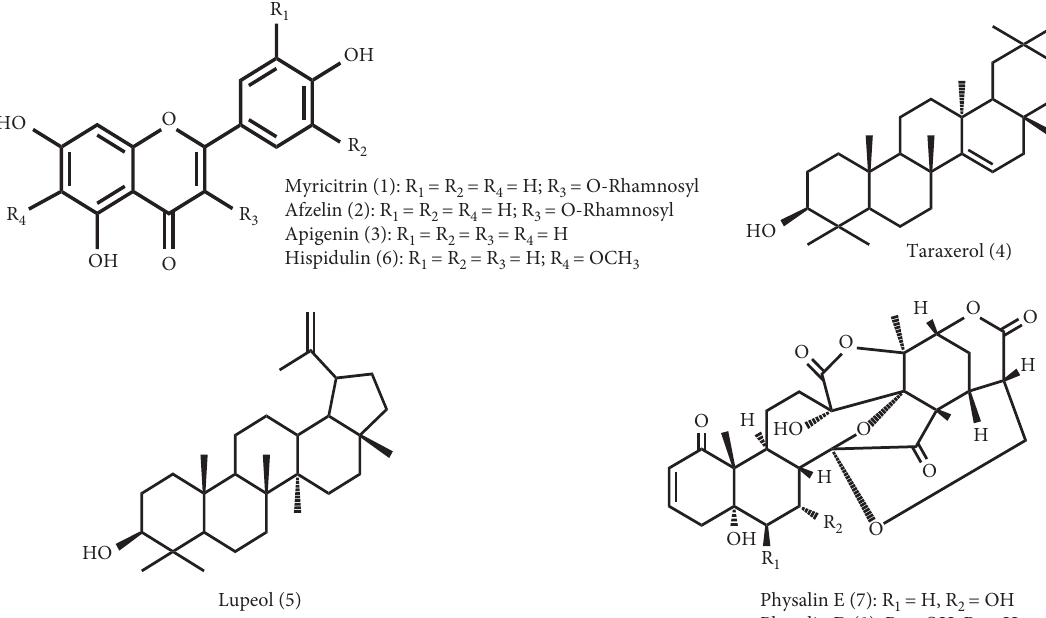
Figure 4: Chemical structure of isolated compounds. (a) Myricitrin ( 1 ): R1 � R R 3 � O-Rhamnosyl. Apigenin ( 3 ): R 1 � R 2 � R 3 � R 4 � H. Hispidulin ( 6 ): R 1 � R 2 � R 3 � H; R 4 � OCH 3 . (b) Taraxerol (4). (c) Lupol (5). (d) Physalin